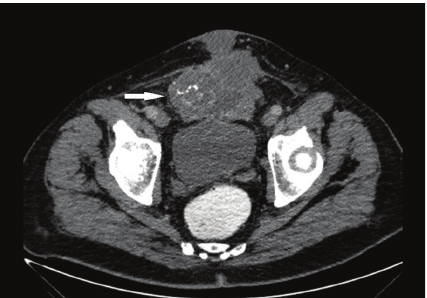
Figure 1: Cross-section contrast-enhanced computed tomography (CECT). There is a heterogeneous lesion (arrow) filling the bladder, extending to the anterior, and containing punctate amorphous